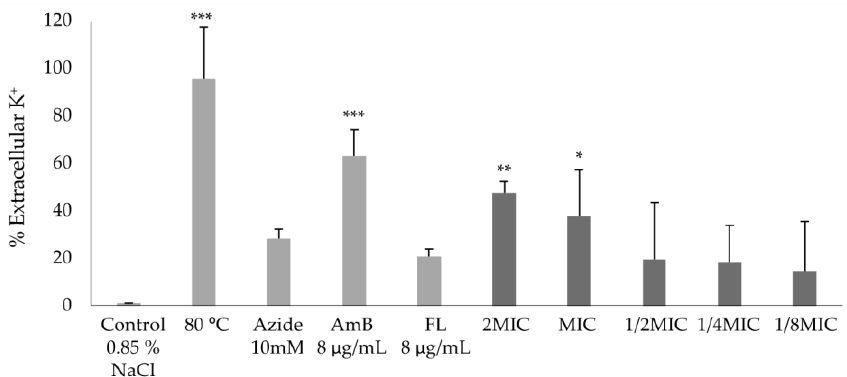
Figure 7. Potassium ion efflux of Candida albicans ATCC 10231 cells treated with different concentra- tions of compound 1 , five min after exposure. Data are shown as mean ± standard deviation of at least three independent assays. Controls included untreated cells incubated for 20 min at 80 ◦ C, 10 mM sodium azide, amphotericin B (AmB), and fluconazole (FL) at 8 µ g/mL. MIC: Minimal inhibitory concentration. * p < 0.05, ** p < 0.01, *** p < 0.001 (one-way ANOVA followed by Dunnett’s test).